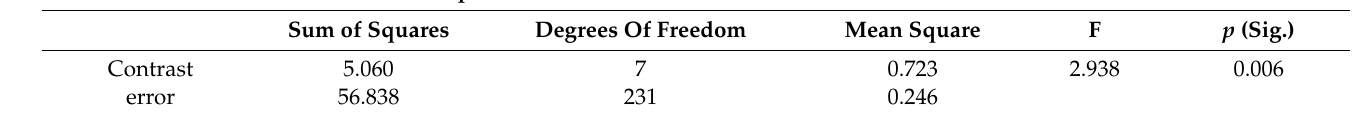
Table 4. Univariate tests.